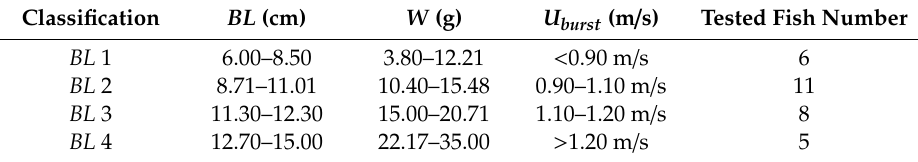
Table 1. Classification of tested juvenile grass carp based on burst swimming speed.